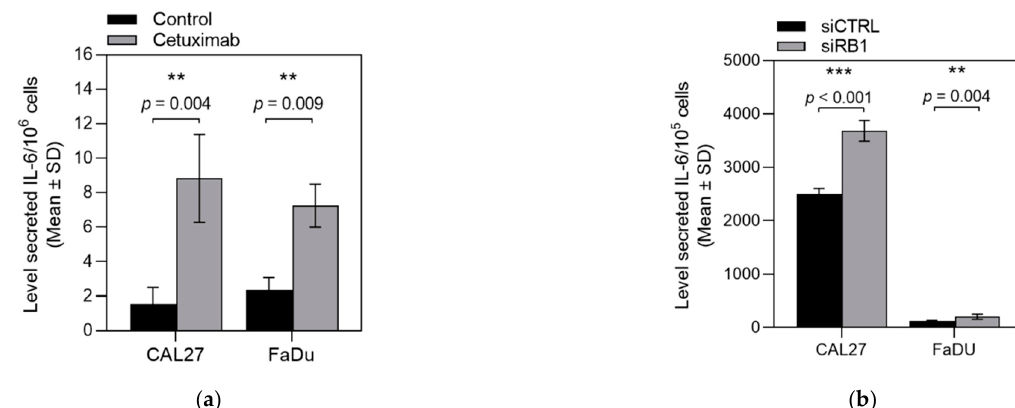
Figure 6. ( a ) IL-6 levels in the cell culture supernatants of the CAL27 and FaDu cetuximab-resistant cell lines compared to parental cells. ( b ) IL-6 levels in the cell culture supernatants of CAL27 and FaDu cells treated with siRNA targeting RB1. ** p < 0.001; *** p < 0.0001.